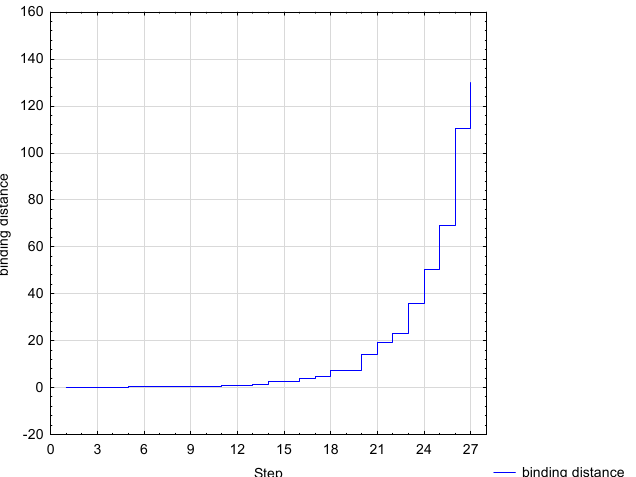
Figure 1. Results binding distance according to binding steps. Source: own elaboration based on data from [7].